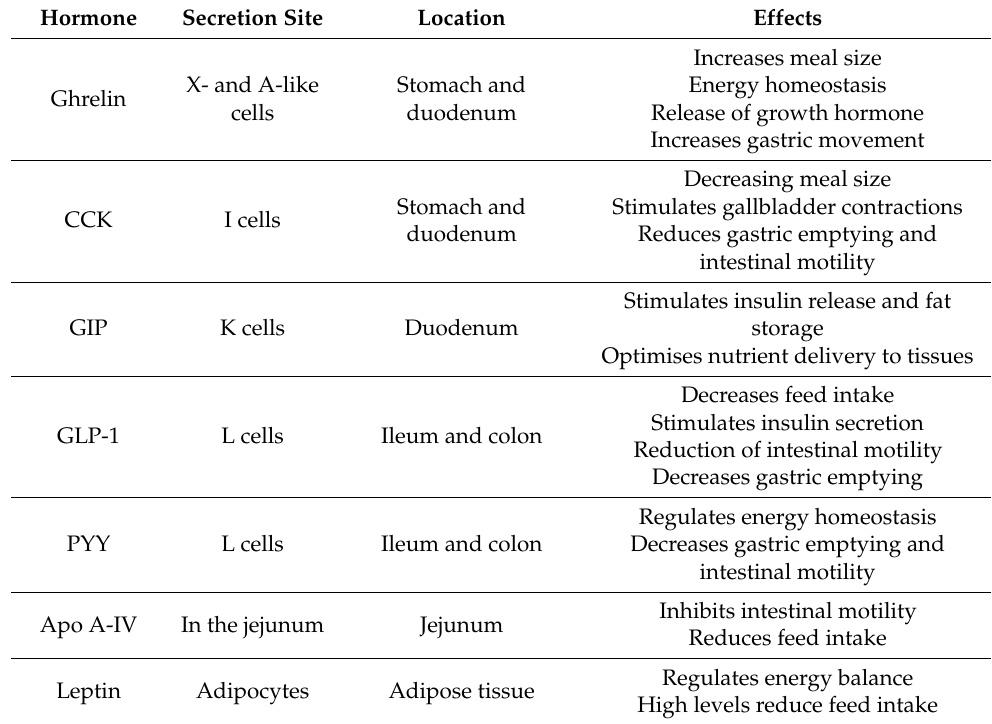
Table 1. Feed intake regulating hormones secretion site and their